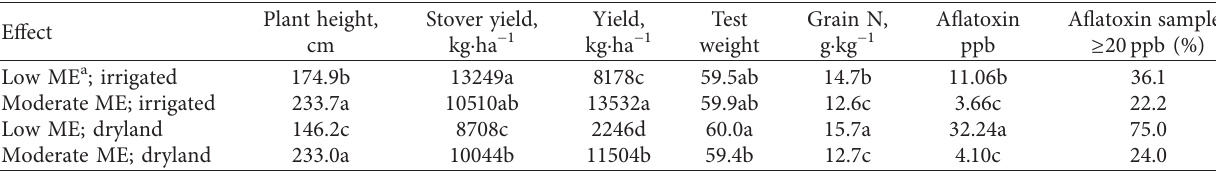
Table 6: Average plant height, stover yield, yield, test weight, grain N concentrations, and aflatoxin content measured across irrigated and dryland treatments within low- and moderate- moisture environments for five site-years during the 2011 to 2014 growing seasons across northern and central